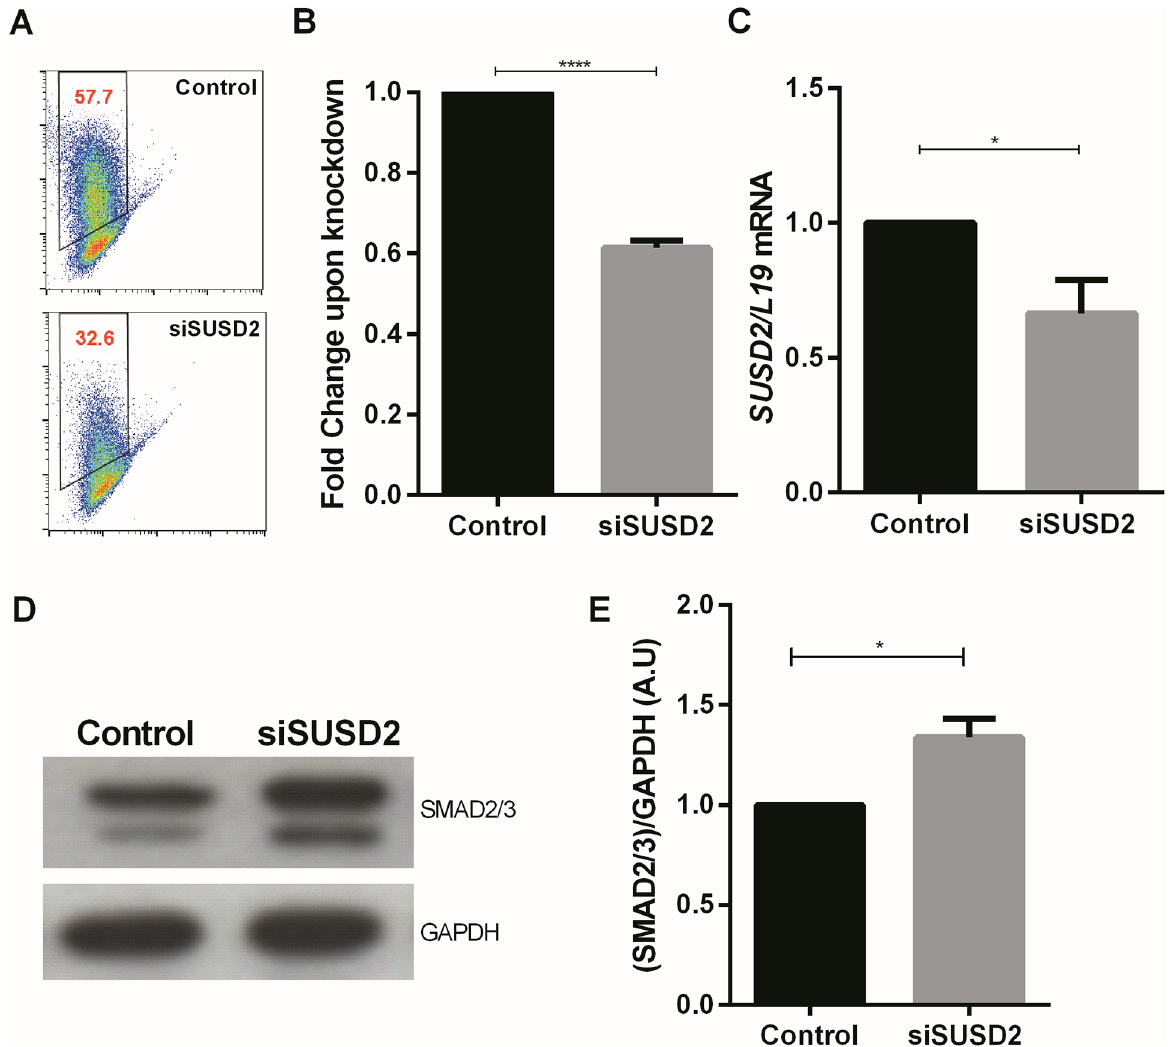
Fig 2. Effect of SUSD2 knockdown on SMAD2/3 expression. (A) Representative originalFACS plots showingSUSD2 knockdown. (B) Arithmetic means ± SEM (n = 5) of SUSD2+ Ishikawacells. Data are depictedas fold inductionrelative to non-targeting siRNA (Control) samples. **** P < 0.0001 indicatesstatisticallysignificant difference from control cells using Student’st-test. (C) Arithmetic means ± SEM (n = 4) of SUSD2 transcript levels normalizedto L19 transcript levels in Ishikawacells. Data are depictedas fold induction relative to transcript levels of control samples. * P < 0.05 indicatesstatistically significantdifference from control cells using Student’s t- test. (D) Representative originalWestern blot of SMAD2/3 and GAPDH in Ishikawa cells. (E) Arithmetic means ± SEM (n = 7) of SMAD2/3 ratio normalized to GAPDH in Ishikawa cells. * P < 0.05 indicatesstatisticallysignificantdifference from control cells using Student’s t-test.